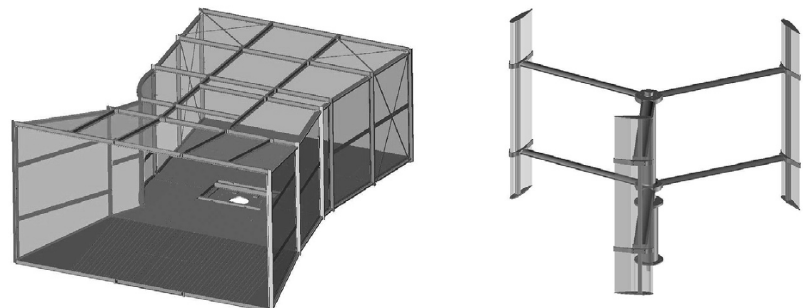
Figure 3. Schematic of the AM300: A micro VAWT with convergent duct [26].